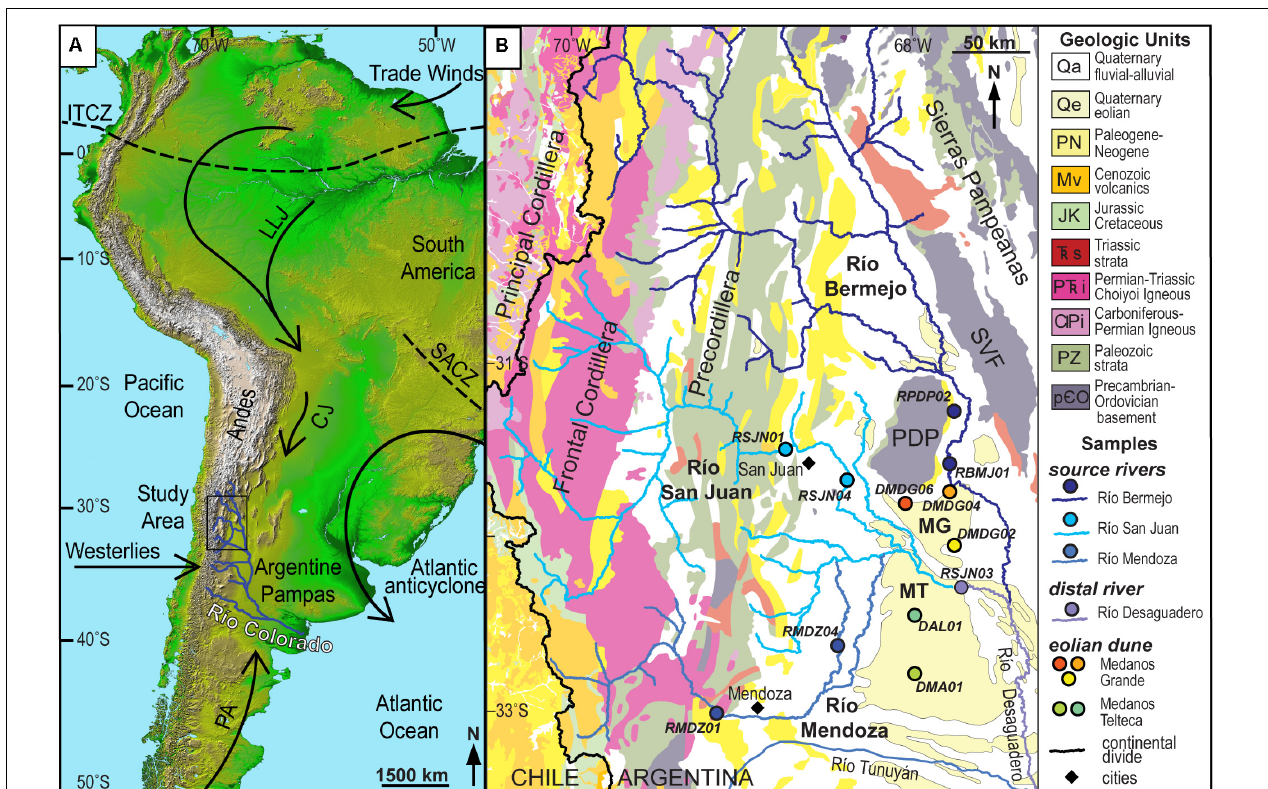
FIGURE 2 | (A) Topographic relief map of South America highlighting Río Colorado sediment routing network and regional wind currents (black lines), Intertropical Convergence Zone (ITCV), Low Level Jet (LLJ), South American Convergent Zone (SACZ), Chaco Jet (CJ), Polar Advections (PA) (modified from Tripaldi and Forman, 2016). (B) Geologic map of west-central Argentina indicating the tectonic provinces, fluvial networks (blue lines), and modern river and eolian sample locations (colored circles). Medanos Telteca (MT), Medanos Grande (MG), Sierra Pie de Palo (PDP), Sierra Valle Fértil